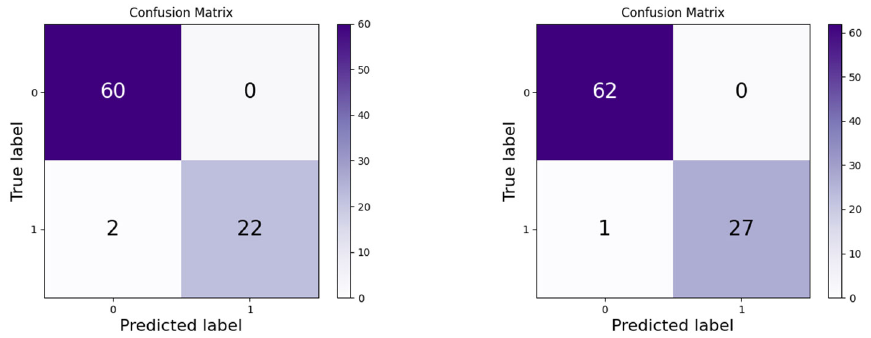
Figure 6. Confusion matrix for backward ( left ) and forward ( right ) classification results using IST dataset gait energy maps.